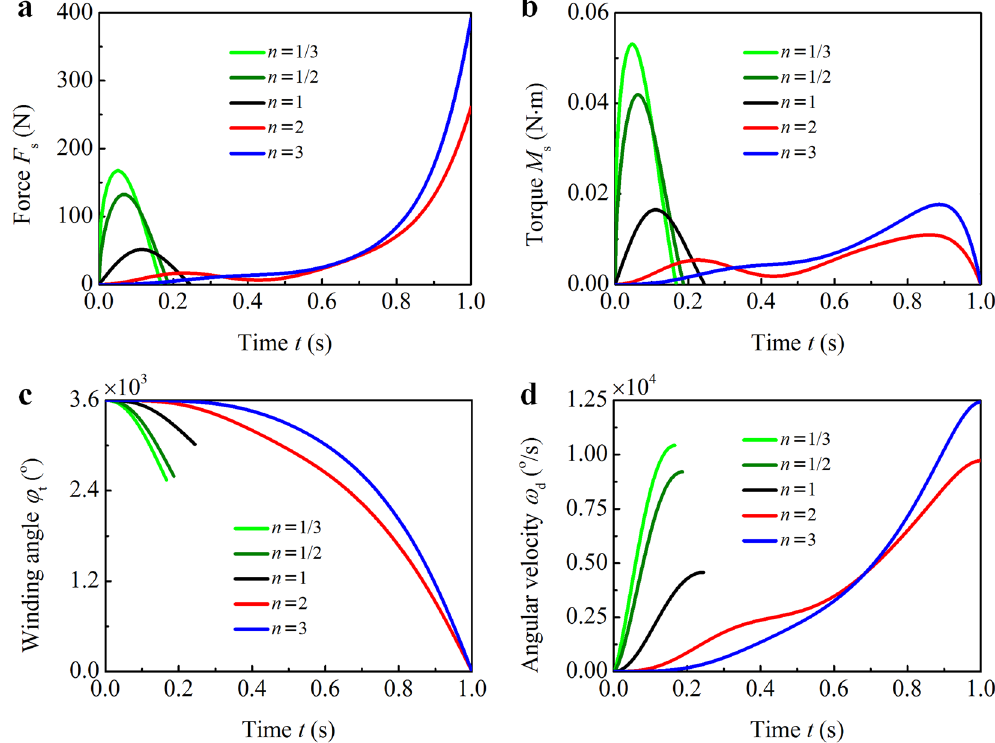
Figure 2. Influence of the loading rate on the unwinding dynamics. ( a ) Tensile force F s and ( b ) torque M s of the string, ( c ) winding angle ϕ t of the threads, and ( d ) angular velocity ω d of the disk are plotted with time t for different loading rates  ε